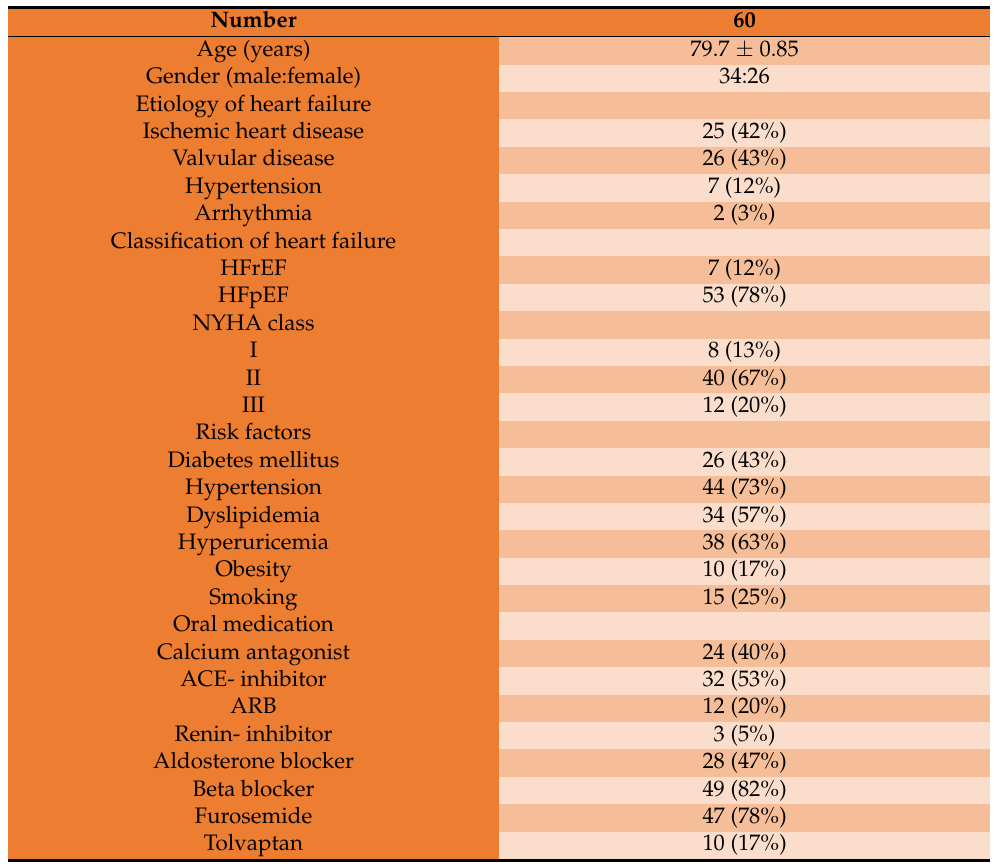
Table 2. Patient characteristics.